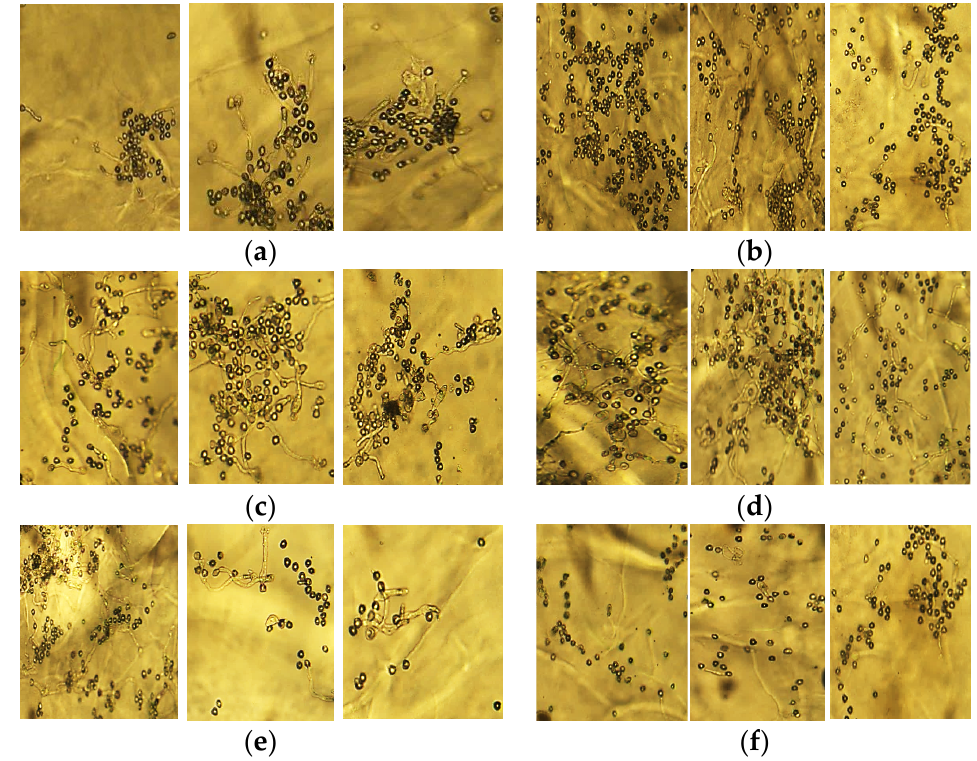
Figure 3. Comparison of pollen germination from storage temperatures 0, 4 and 8 °C (from the left). Storage time: ( a ) 0 days; ( b ) 4 days; ( c ) 8 days; ( d ) 12 days; ( e ) 16 days; ( f ) 20 days.